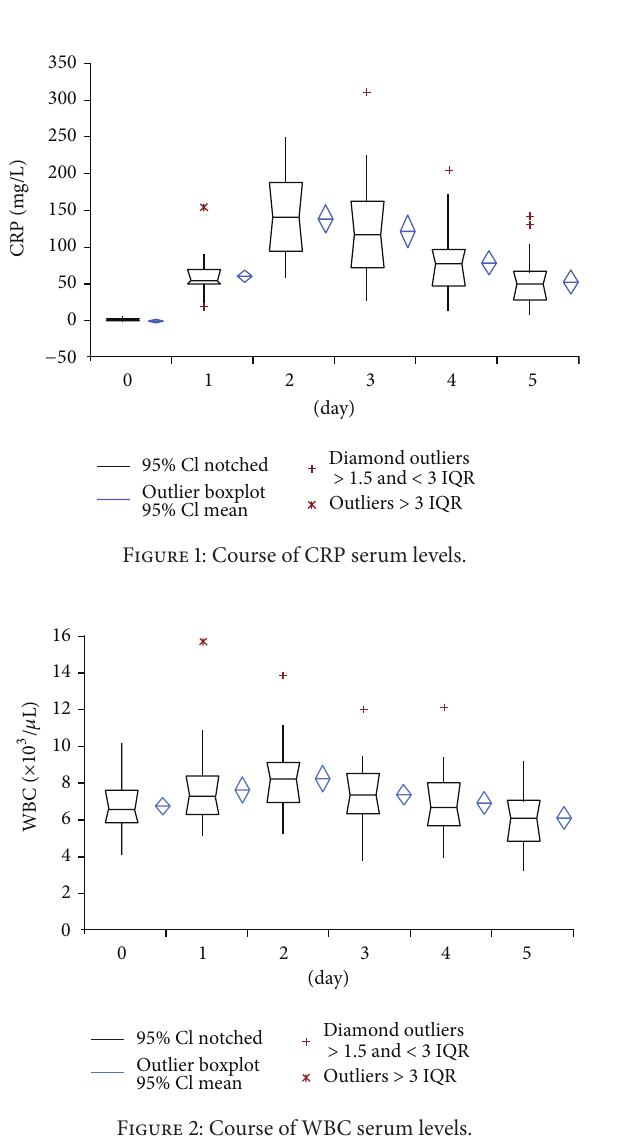
Figure 2: Course of WBC serum levels.